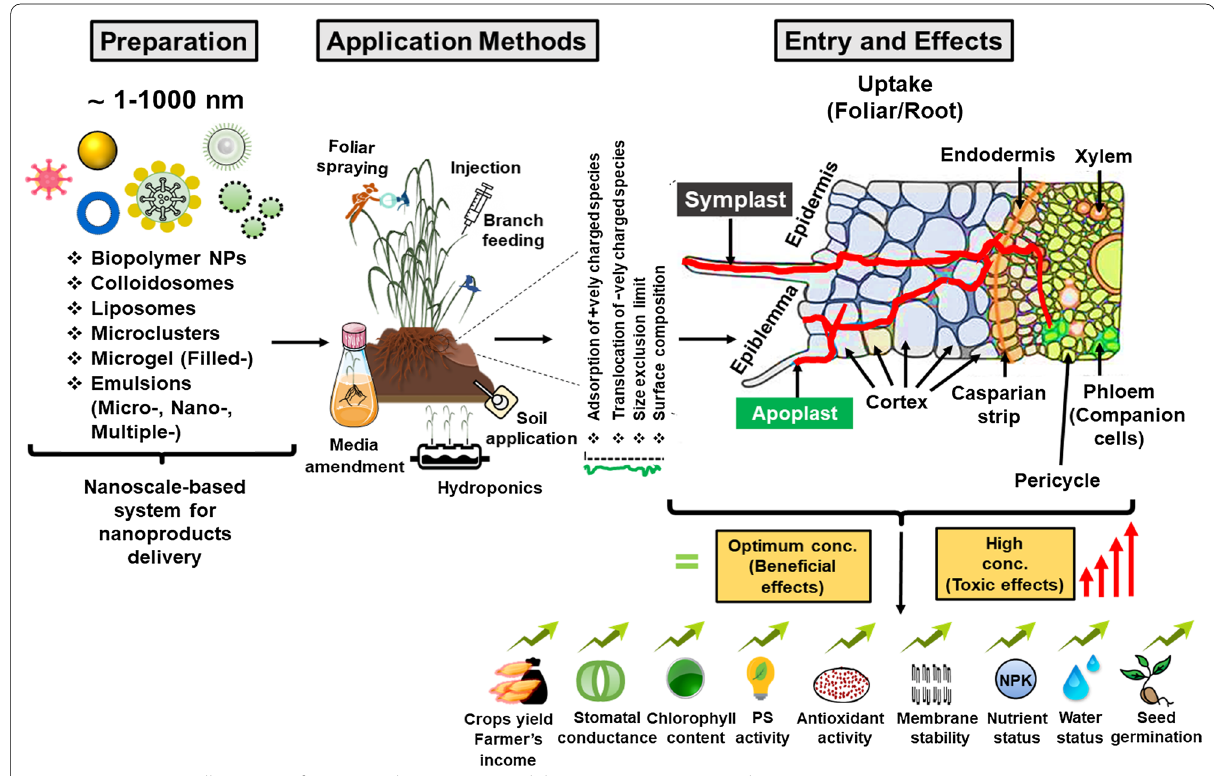
Fig. 1 Diagrammatic illustration of nanoparticles transport, and their interactions in crop